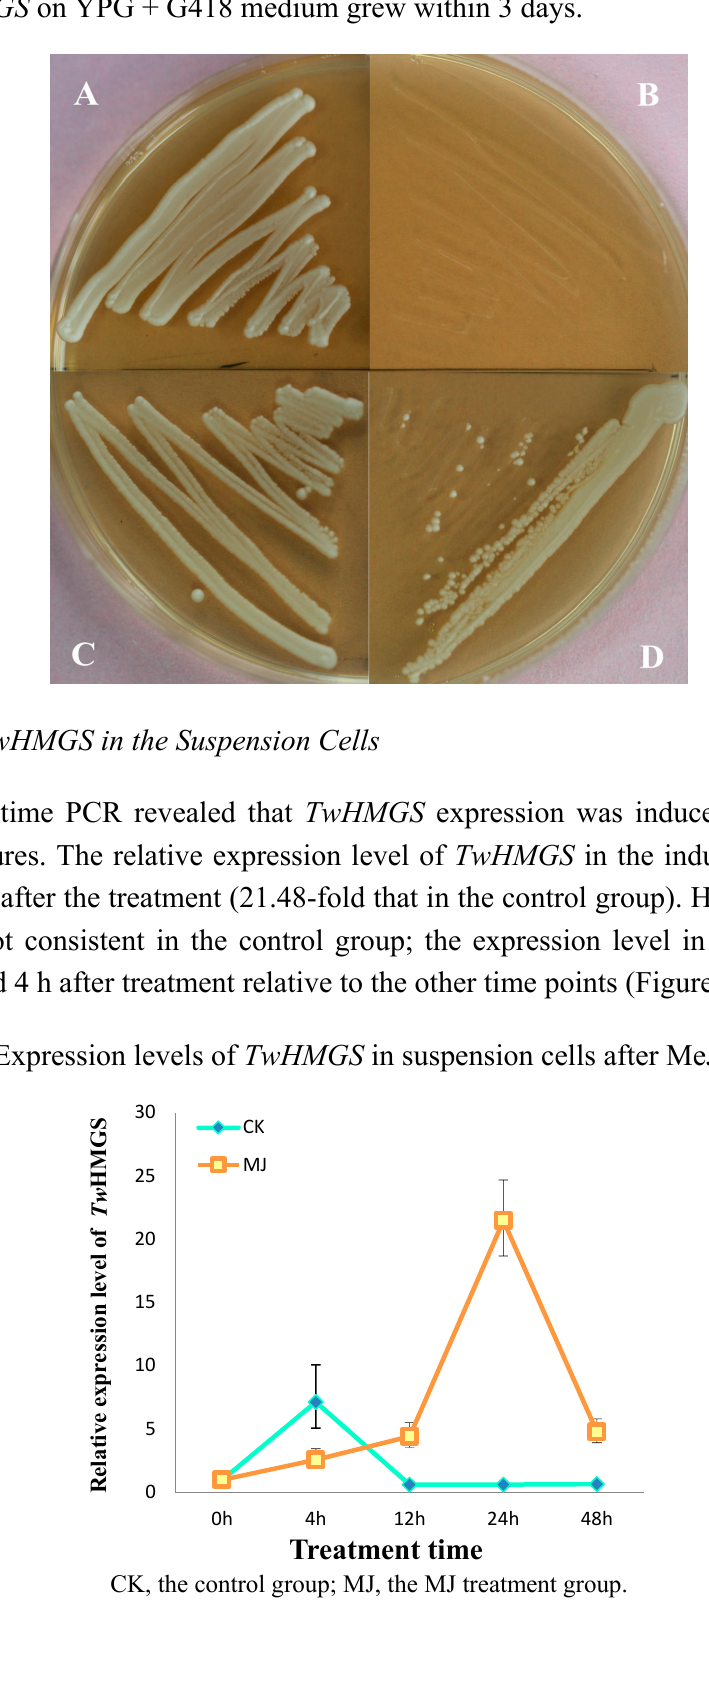
Treatment CK, the control group; MJ, the MJ treatment group.